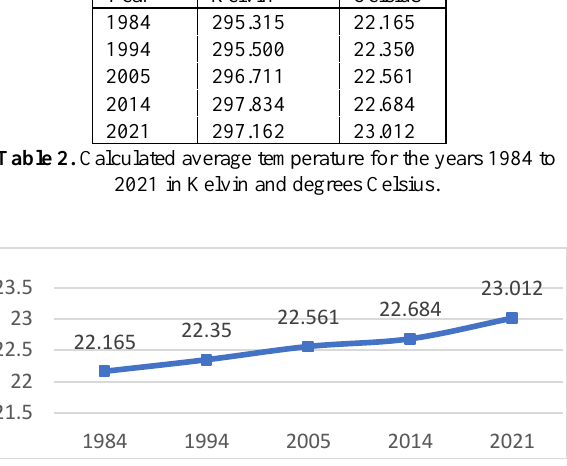
Figure 8. Temperature changes in the control area in degrees Celsius.